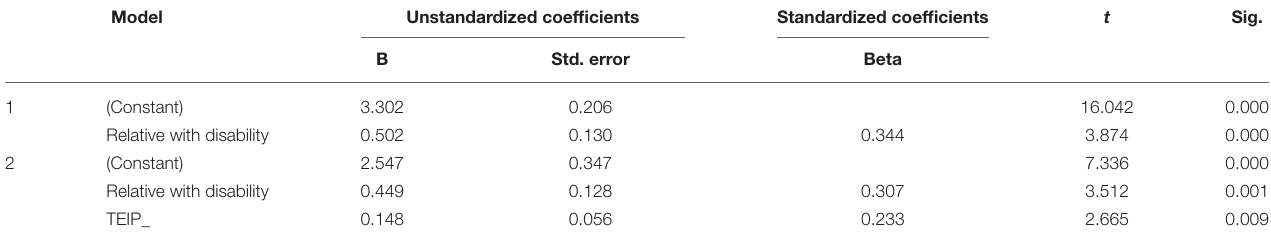
TABLE 4 | Multiple regression coefficients to predict teachers’